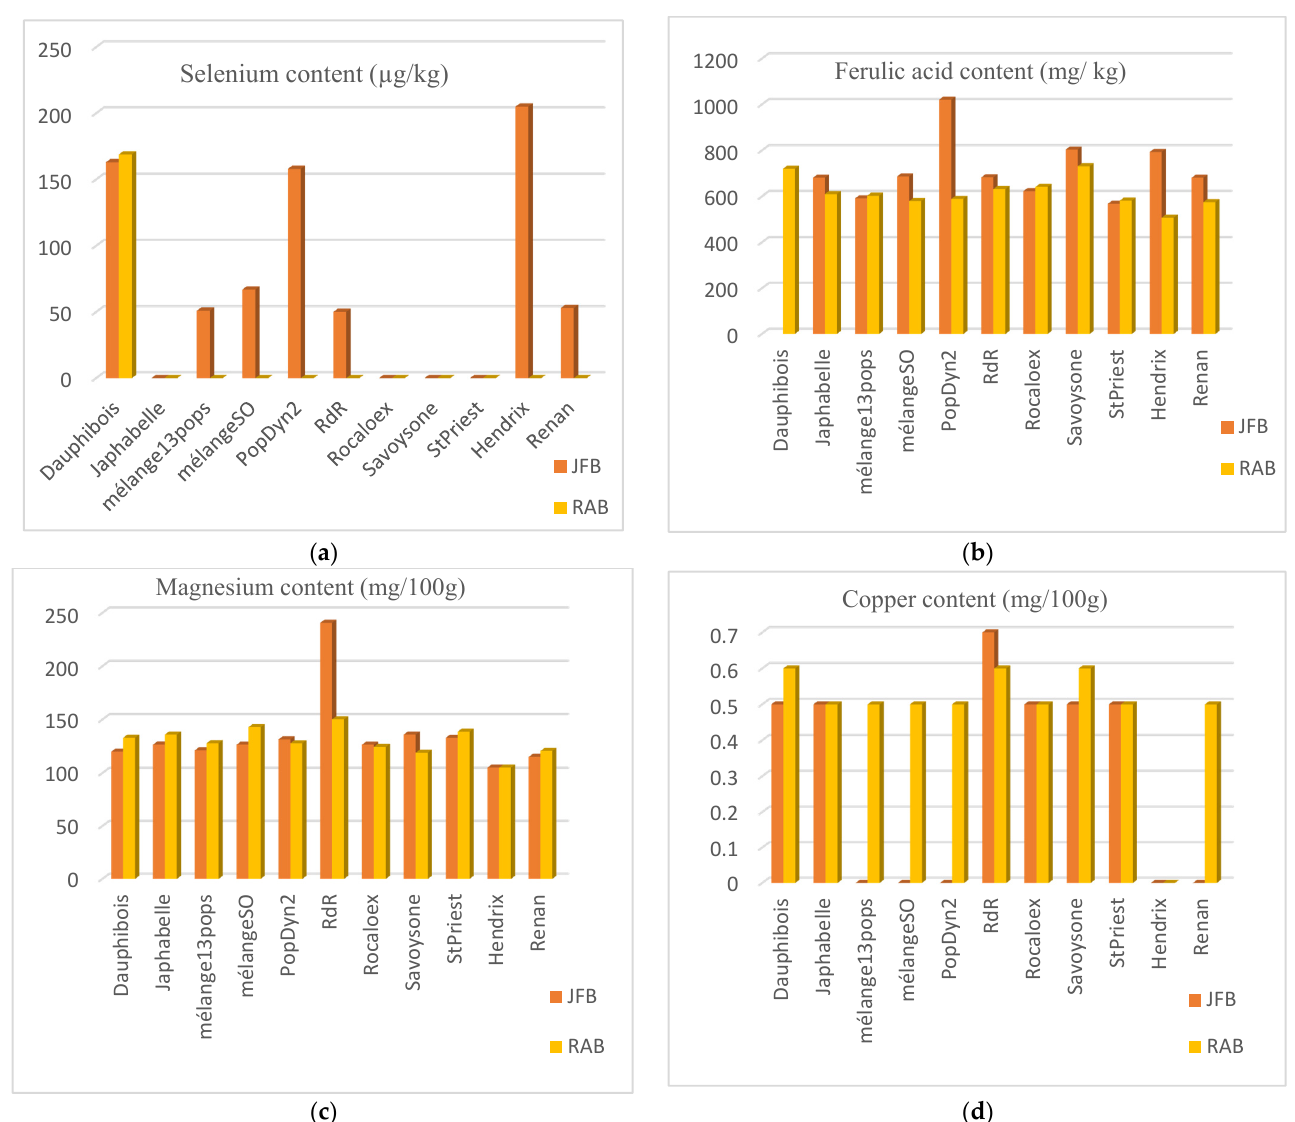
Figure 4. Content in ( a ) Se (µk/kg), ( b ) ferulic acid (mg/kg), ( c ) Mg (mg/100 g) and ( d ) Cu (mg/100 g) for 11 wheat varieties grown in two environments (JFB and RAB).